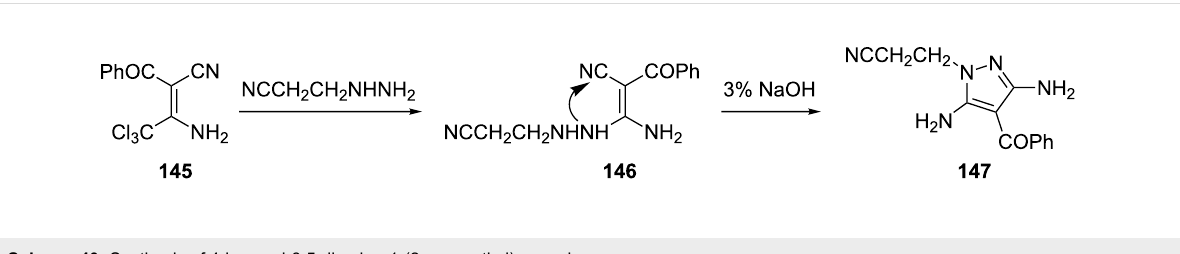
Scheme 40: Synthesis of